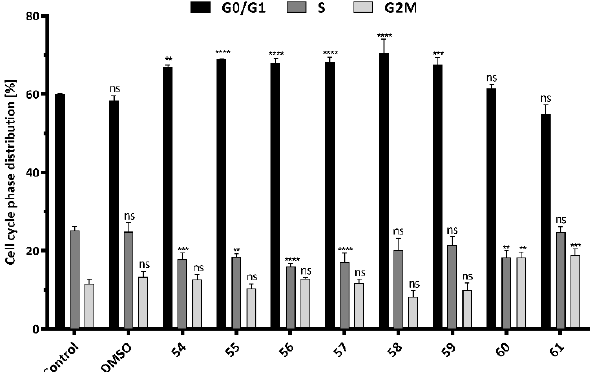
Figure 4. Effect of compounds 54 (5.5 µM), 55 (3.4 µM), 56 (12 µM), 57 (3.1 µM), 58 (3.9 µM), 59 (5.4 µM), 60 (31 µM), and 61 (4.8 µM) on cell cycle distribution in HepG2 cells. The cells were treated (5.4 µ M), 60 (31 µ M), and 61 (4.8 µ M) on cell cycle distribution in HepG2 cells. The cells were